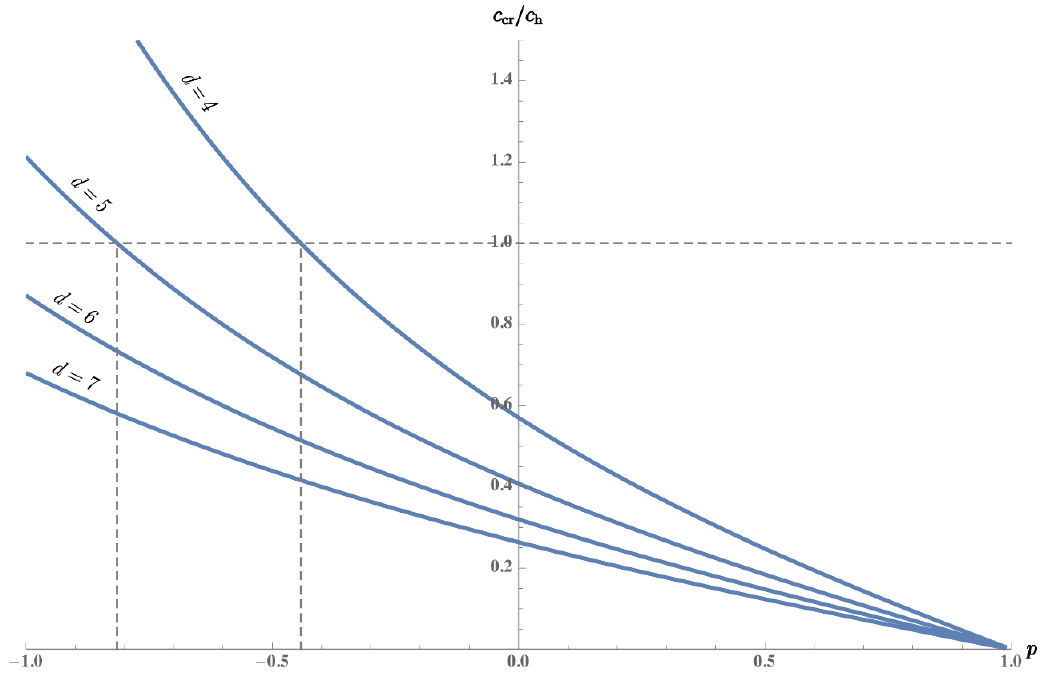
for any Kasner-AdS, for h